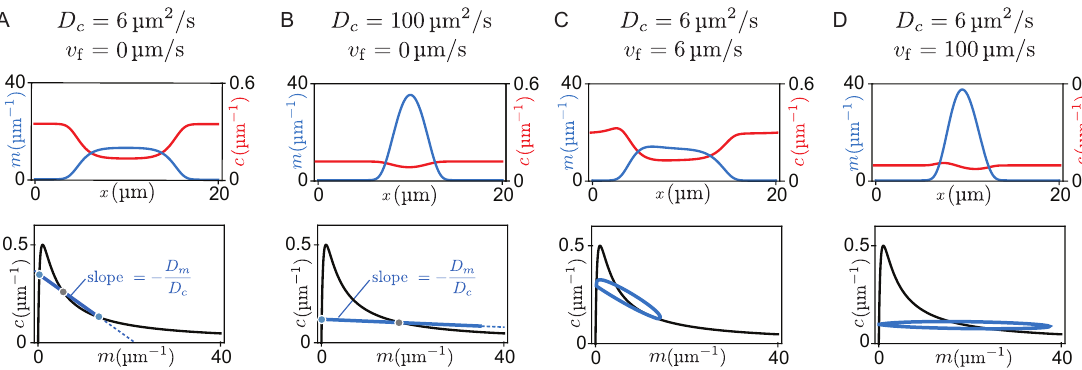
Figure 5. Demonstration of the transition from a mesa pattern to a peak pattern. Each panel shows a snapshot from finite element simulations in steady state. Top concentration profiles in real space; bottom: corresponding trajectory (blue solid line) in phase space. ( A ) Mesa pattern in the case of slow cytosol diffusion and no flow. The two plateaus (blue dots) and the inflection point (gray dot) of the pattern correspond to the intersection points of the FBS (blue dashed line) with the reactive nullcline (black line). ( B ) For fast cytosol diffusion, the third intersection point between FBS and nullcline lies at much higher membrane concentration such that it no longer limits the pattern amplitude. Therefore, a peak forms whose amplitude is limited by the total protein mass in the system. ( C ) Slow flow only slightly deforms the mesa pattern, compare to ( A ). Fast cytosolic flow leads to formation of a peak pattern ( D ), similarly to fast diffusion. Parameters: ¯ n = 7µm − 1 , D m = 0.1µm 2 /s, and L =